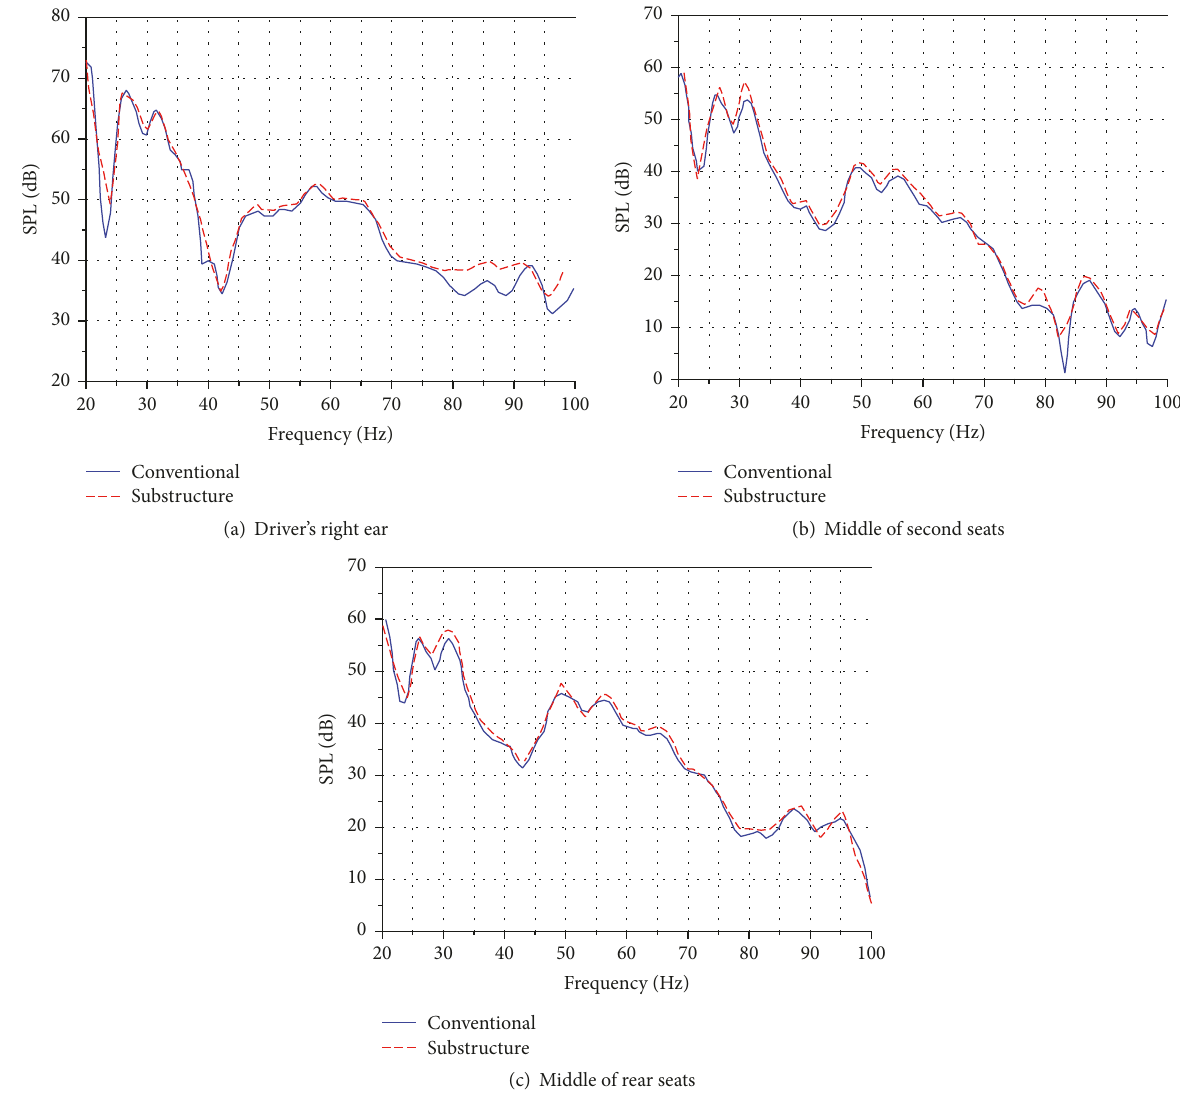
Figure 12: Characteristics of interior noise